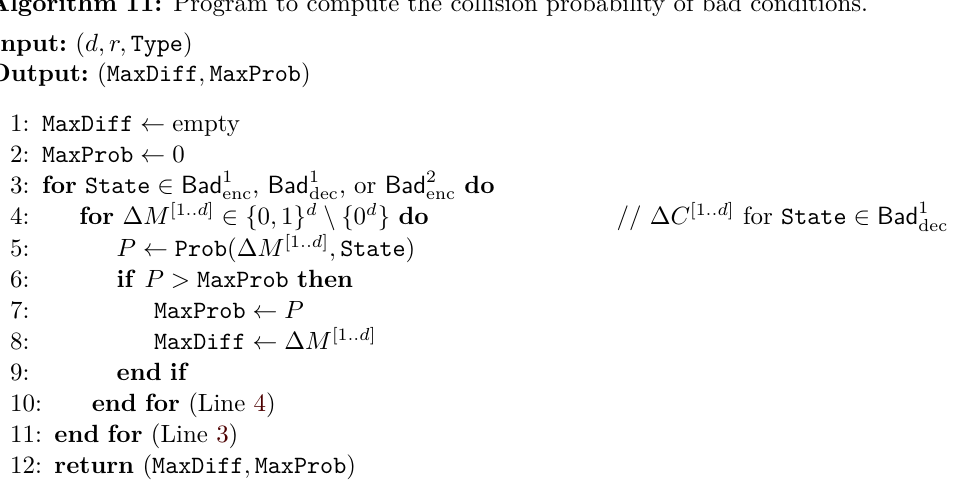
, or Bad 2 in Line 3. , Bad 1 enc dec enc